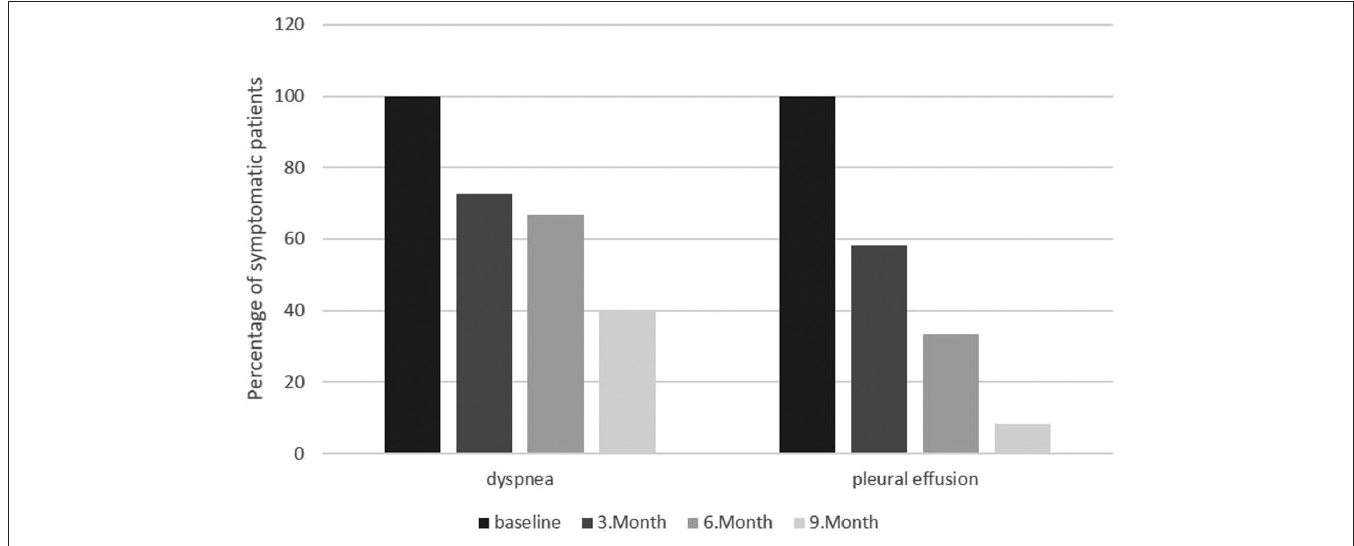
Figure 2. Temporal change of dyspnea and pleural effusion. Improvement/decrease in dyspnea over time was statistically significant ( P = .037). Improvement/ decrease in pleural effusion over time was statistically significant ( P =